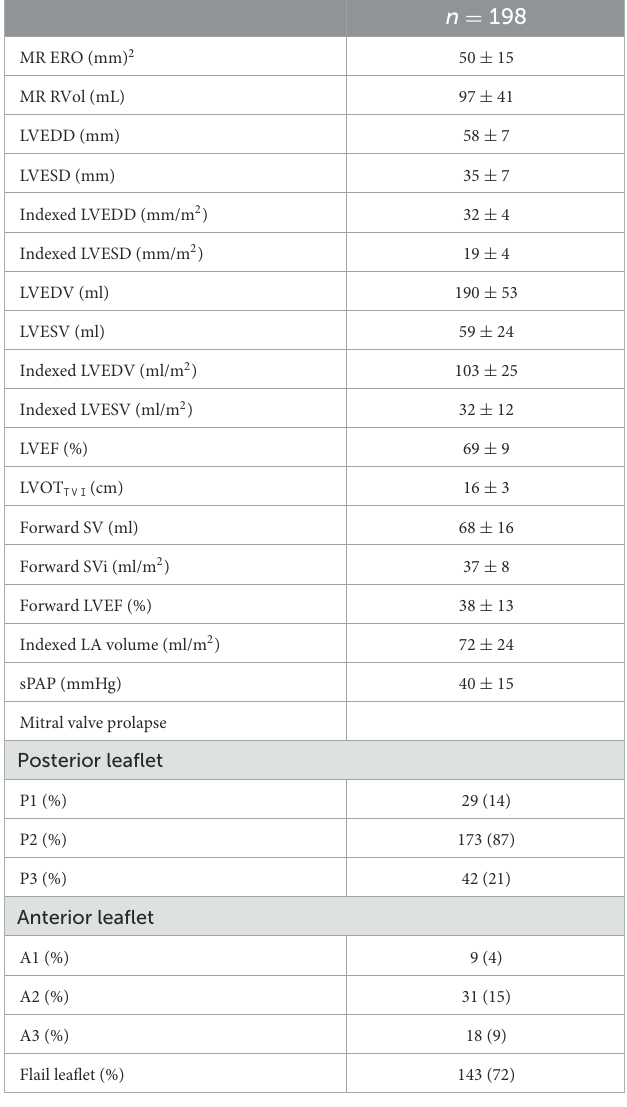
TABLE 2 Pre-operative echocardiographic characteristics of 198 patients subject to mitral valve repair for severe